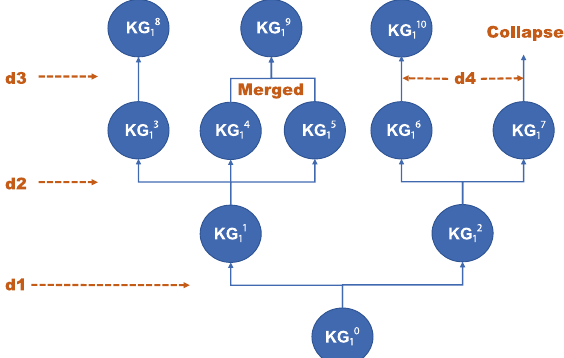
Fig. 8 Evolving multiverse of knowledge graphs. The original knowledge graph (KG 10 ) is split into two incompatible KGs (KG 11 and KG 12 ) with the addition of a new data “ d1 ” and associated arguments. Further addition of data “ d2 ” resulted in the additional split of KGs. Data d3 and associated argumentation contextualized con fl icting interpretations separating two KGs (KG 14 and KG 15 ) that resulted in the merger of them. Such a merge happens when KG 1 4 and KG 15 are not compatible due to con fl icting interpretation of data d2, but data d3 and associated argumentation clari fi ed con fl ict can be resolved that two interpretation of data d2 is context- dependent thus both interpretations hold in a different context. For two competing KGs (KG 16 and KG 17 ), d4 and associated argumenta- tion eliminated KG 17 , and KG 16 survived and augmented to be KG 110